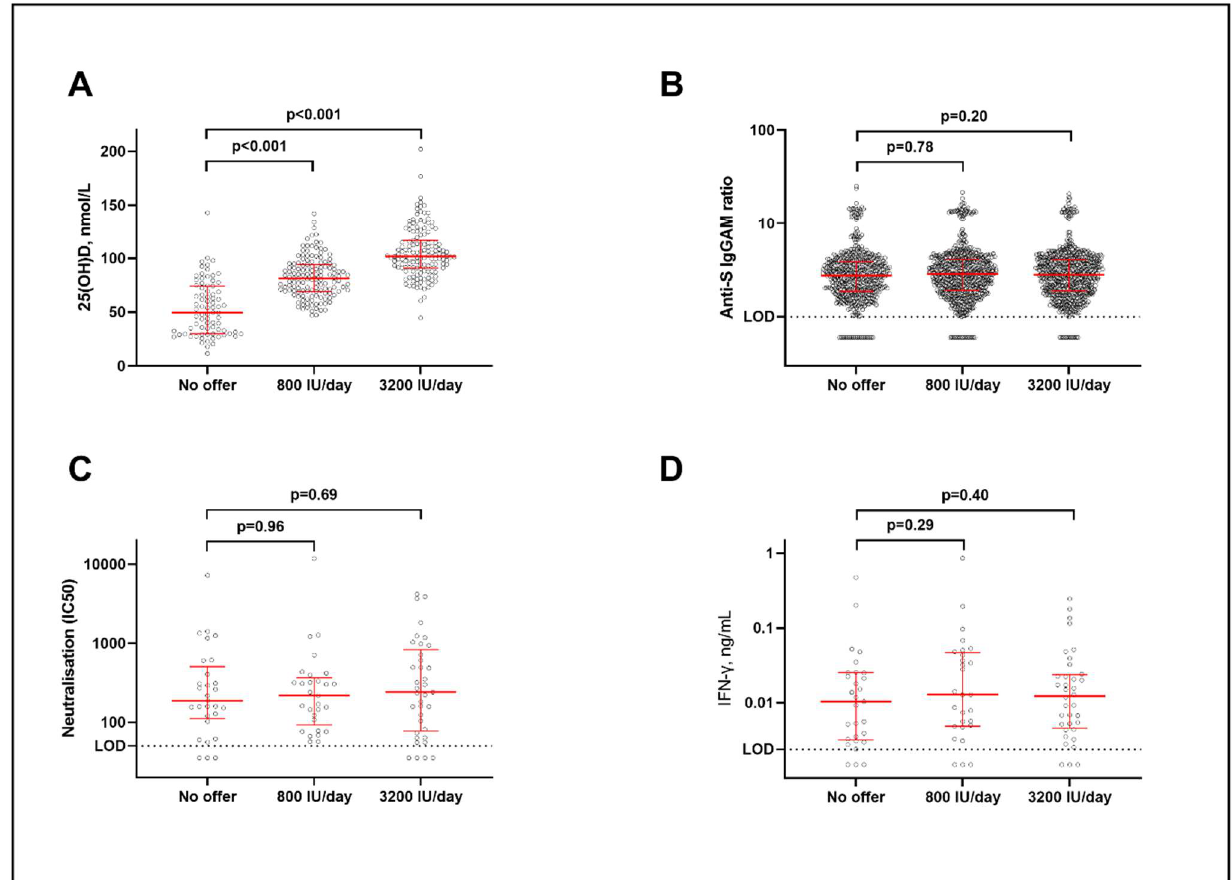
Figure 2. Biochemical and immunological outcomes by allocation. ( A ) End-study 25(OH)D concentrations. ( B ) Anti-S IgGAM titres. ( C ) Neutralising antibody titres. ( D ) IFN-γ concentrations in supernatants from S peptide-stimulated whole blood. Horizontal bars represent medians and interquartile ranges. p values from unpaired t tests ( A ) and multiple linear regression with adjustment for covariates as described in Methods ( B – D ). Here, 25(OH)D = 25-hydroxyvitamin D. Anti-S IgGAM = combined anti-Spike IgG, IgA and IgM response. IFN = interferon. LOD = limit of